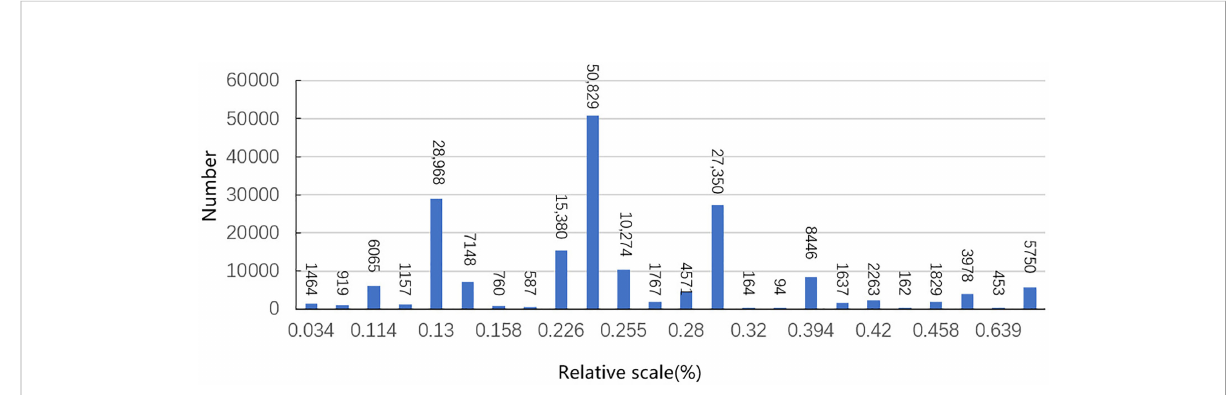
FIGURE 1 Relative size and the number of pests in the dataset. Relative scale represents the ratio of the pest pixel size to the whole image size; number represents the number of pests.